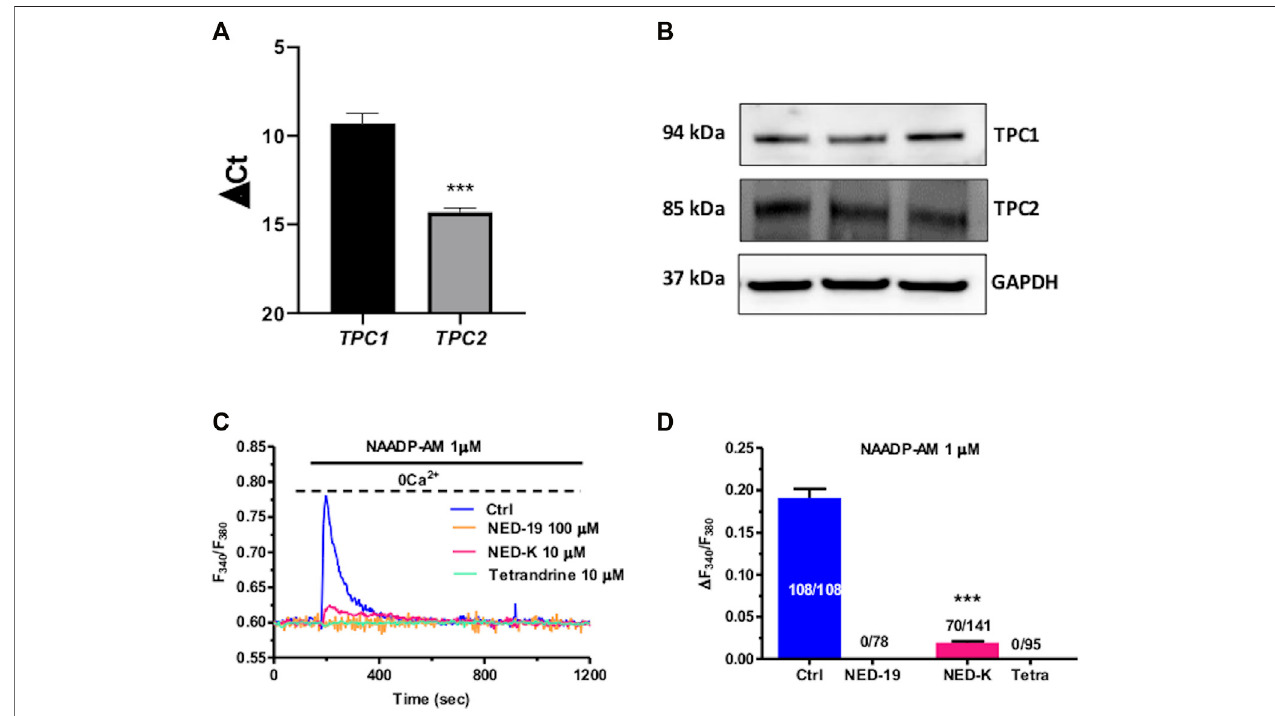
FIGURE2| Two-porechannels(TPCs)mediateNAADP-inducedlysosomalCa 2+ releaseinC-MSCs. (A) TPC1andTPC2geneexpressionintotalRNAextractsof C-MSCs. qRT-PCR data are shown as transcript abundance (genes threshold cycles [Ct] with respect to the house-keeping gene GAPDH). n = 4/group. Student ’ s t-test:*** p < 0.001. (B) WesternBlotanalysisofTPC1andTPC2proteinsintotalcellularextracts. n =3/group. (C) TheCa 2+ responsetoNAADP-AMwassuppressedby incubating the cells with the following TPC inhibitors: NED-19 (100 μ M, 30 min), NED-K (10 μ M, 30 min), and tetrandrine (10 μ M, 30 min). (D) Mean ± SE of the amplitude of the peak Ca 2+ response to NAADP in the absence (Ctrl) and in the presence of NED-19, NED-K and tetrandrine (Tetra). Student ’ s t-test: *** p < 0.001.